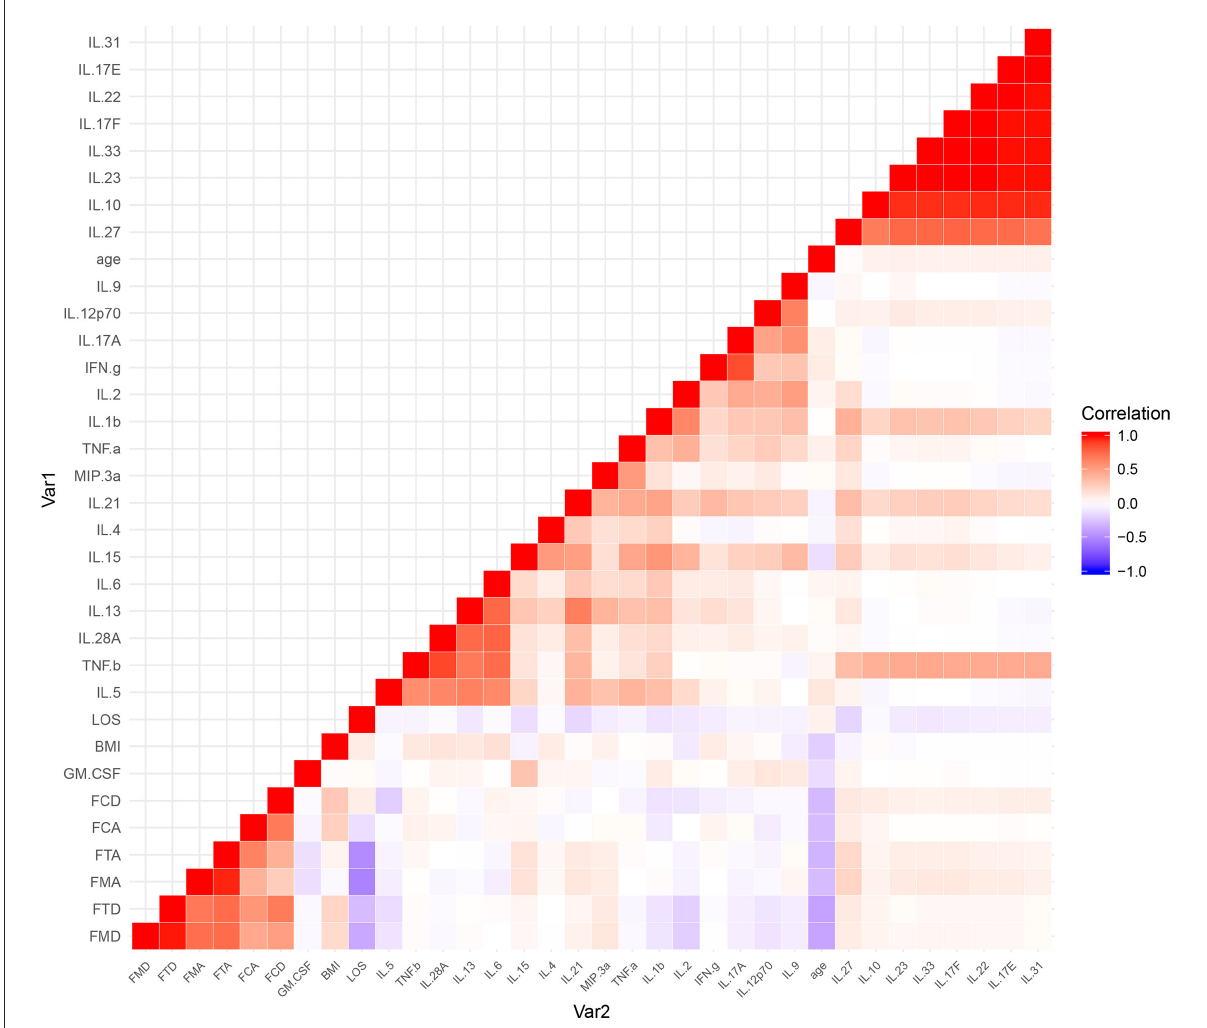
FIGURE4 A heatmap of the correlational coefficients. Variables in graded shades of red (blue) represent their positive (negative) correlations. Representations of the correlation level are listed on the side of the graph. FCA, cognitive FIM score on admission; FCD, cognitive FIM scores at discharge; FMA, motor FIM score in admission; FMD, motor FIM scores at discharge; FTA, total FIM score on admission; FTD, total FIM scores at discharge; LOS, length of stay in